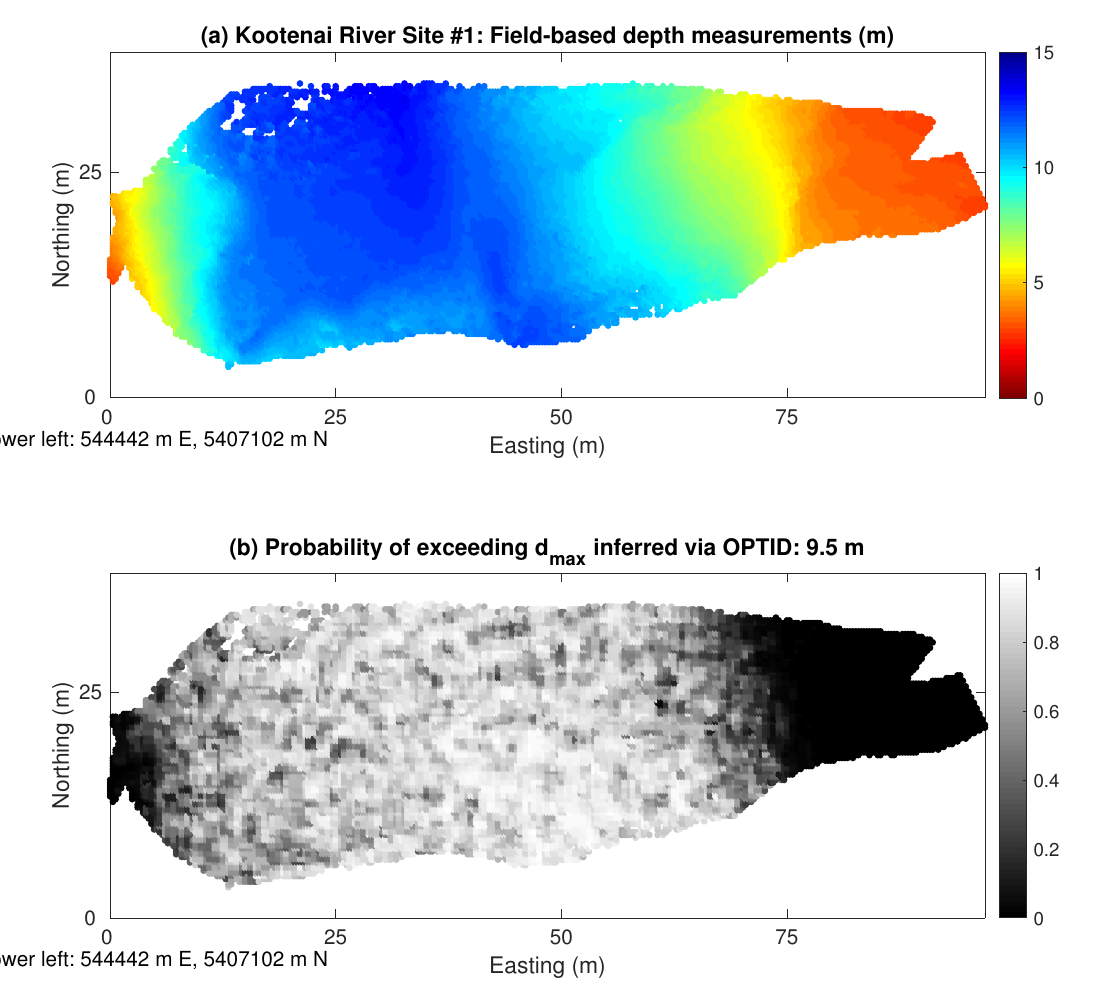
( a ) Field-based depth measurements used for validating image-derived estimates; ( b ) calculated probabilities of optically deep water, Pr ( OD ) , occurring at each pixel based on the pixel’s X value and a logistic regression model for distinguishing optically deep versus shallow